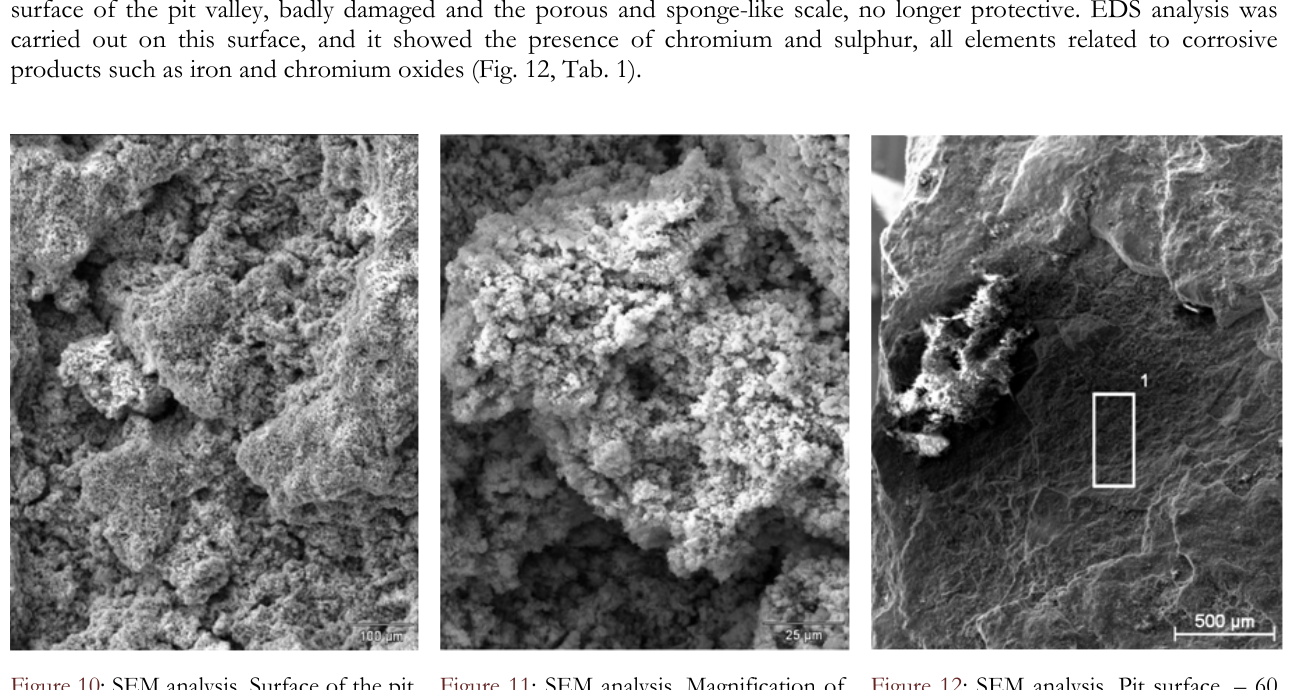
Figure 11: SEM analysis. Magnification of a detail from fig. 10. – 1000 X.